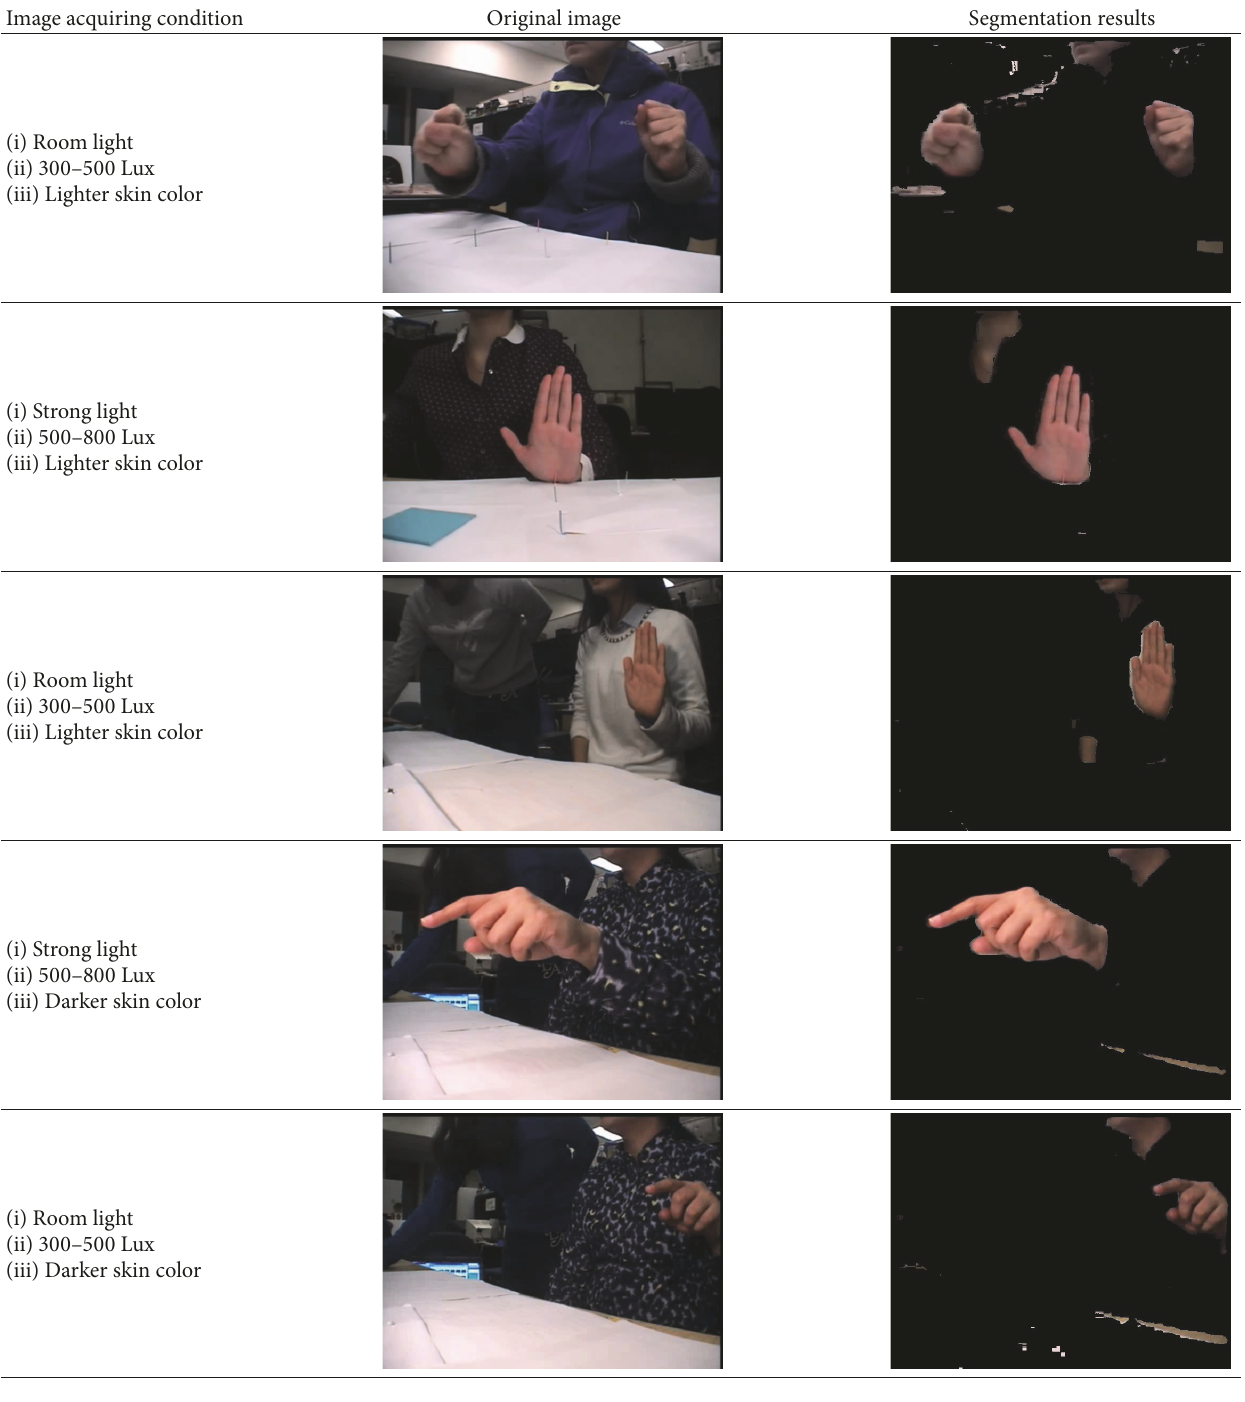
Table 3: The skin segmentation results of fixed-range CbCr